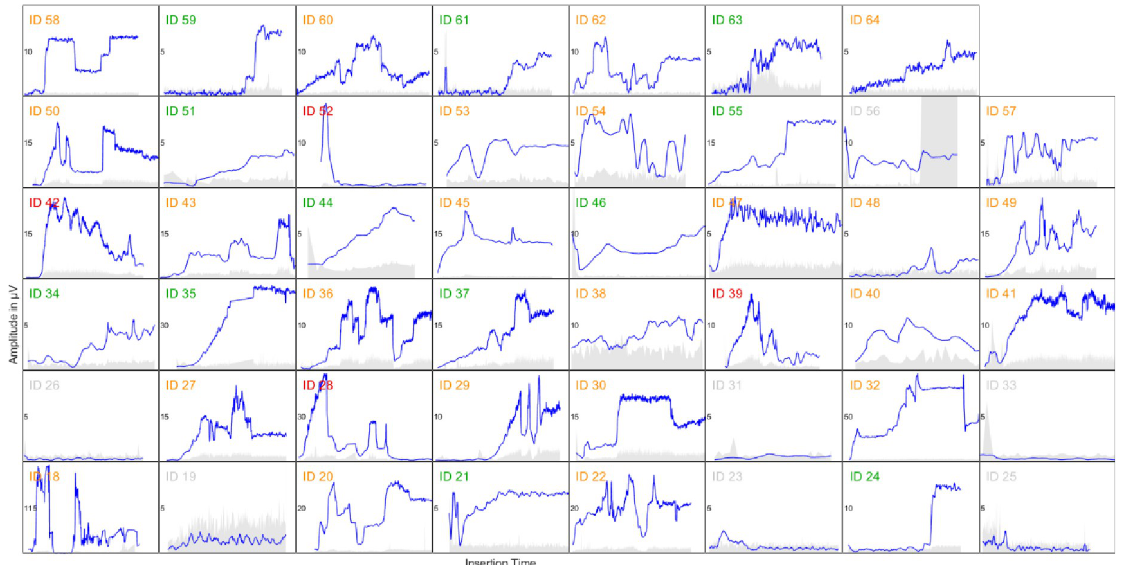
Fig 1. Cochlear microphonic recordings for each subject made intraoperatively via the cochlear implant showing the large variability in responses. Total amplitude of the responses ranged from ~5 μ Vto over 200 μ V(blue line). Light grey area shows the noise floor. The subject ID in each axis is coloured according to the group categorisation (green = Growth, yellow = Fluctuating, red = Total Loss, see also Fig 5).